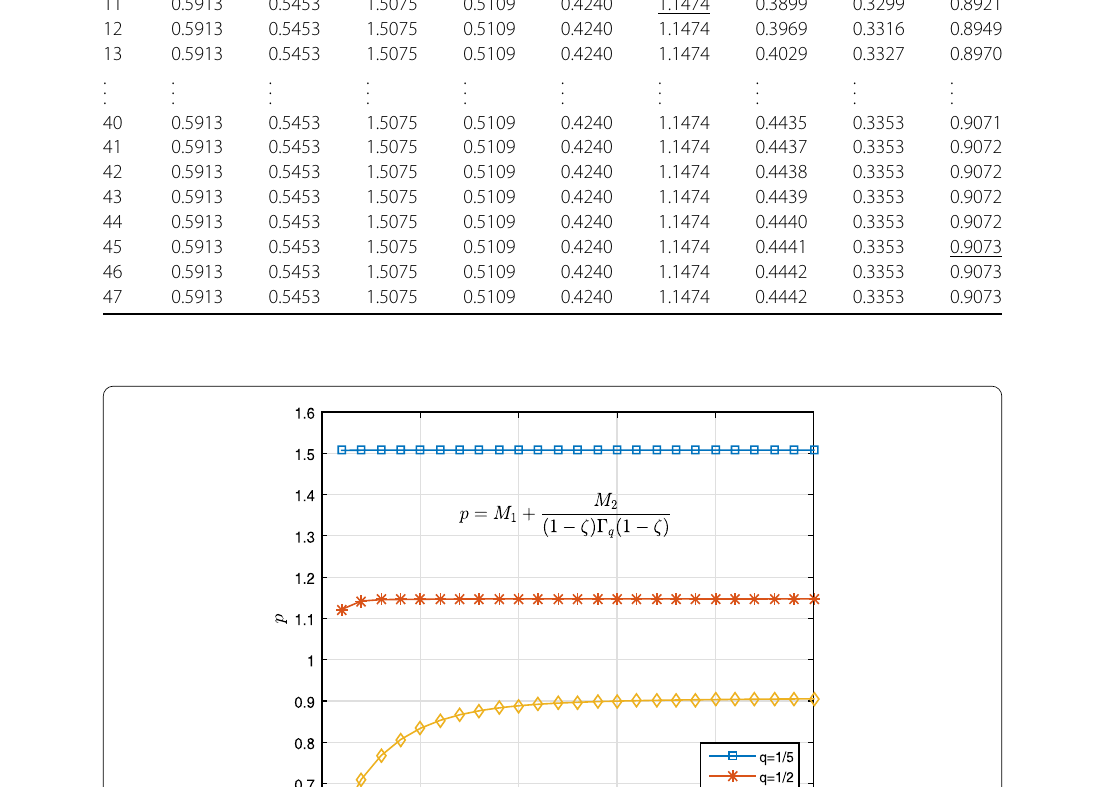
Figure 4 2D graphs of p = M 1